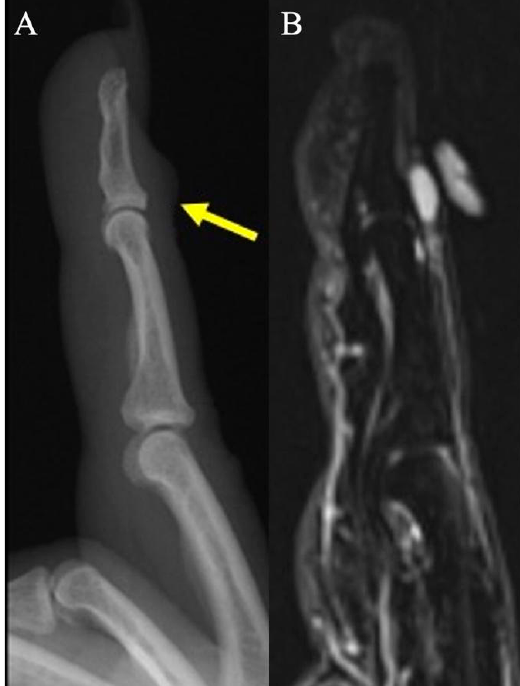
Figure 3. Digital mucus cyst. ( A ) Lateral radiograph of index finger demonstrates focal soft ‐ tissue swelling dorsal to the DIP joint, just proximal to the nail fold. ( B ) Sagittal fat ‐ suppressed PD MRI shows a small uniformly hyperintense cyst, in keeping with a digital mucus cyst, without subungual extension or osseous erosion.